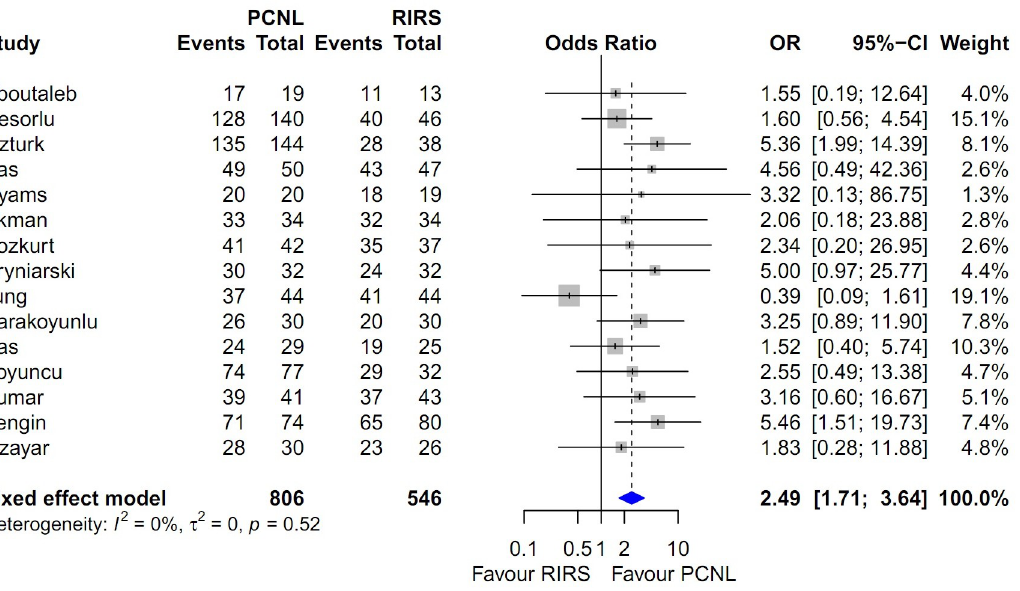
PLOS ONE | https://doi.org/10.1371/journal.pone.0211316 February 21,